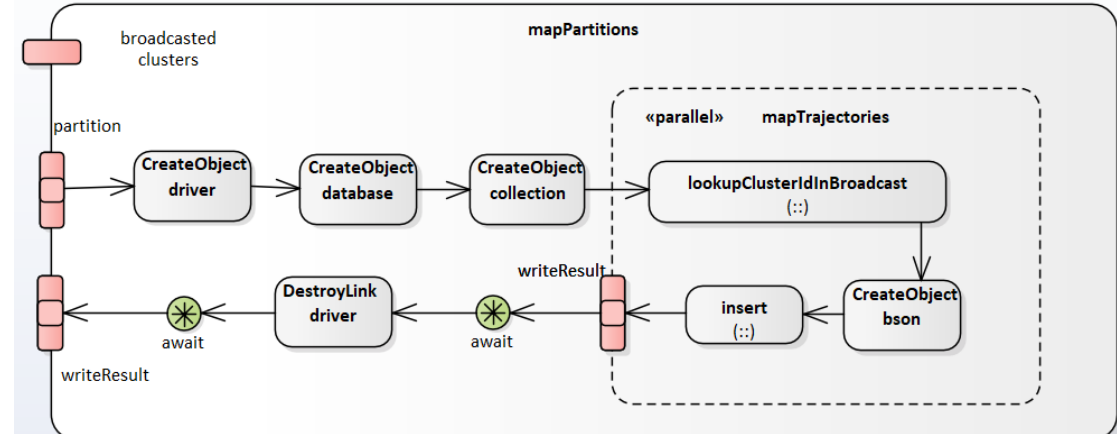
Figure 5. The join and persistence process.